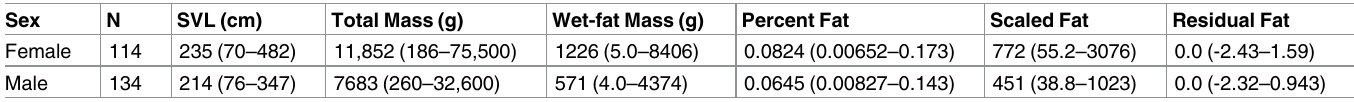
Table 2. Summaryof snout-vent length (SVL), total mass, wet-fat mass, percent fat, scaled fat, and residual fat data from 248 Burmese pythons collected in southern Florida during 2004–2014. Values are expressedas: mean (total range). Females in this dataset are generallylonger, heavier, and fatter than males.